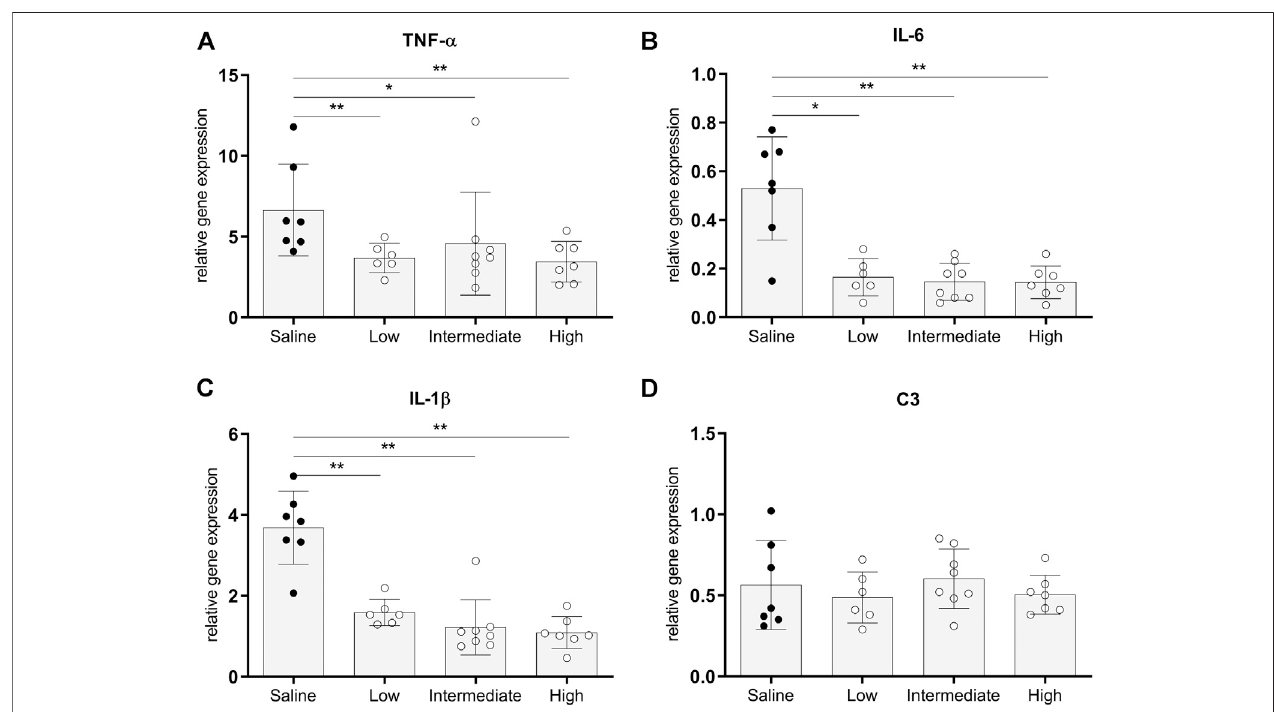
FIGURE4| Pro-in fl ammatorygeneexpressions inlung tissue.Brain death (BD)wasinducedinrats assignedtoone offourexperimentalgroups, etc. and 1 hafter BD induction rats were treated intravenously with 1) 0.9% saline (control) 2) low dose methylprednisolone (5 mg/kg of bodyweight (BW), 3) intermediate dose methylprednisolone(12.5 mg/kgofBW)and4)highdosemethylprednisolone(22.5 mg/kgofBW).mRNAgeneexpressionlevelsof (A) TNF- α , (B) IL-6, (C) IL-1 β and (D) C3. Data are shown as expressions relative to housekeeping gene β -actin. Values are presented as mean ± SD. * p < 0.05, ** p < 0.01.